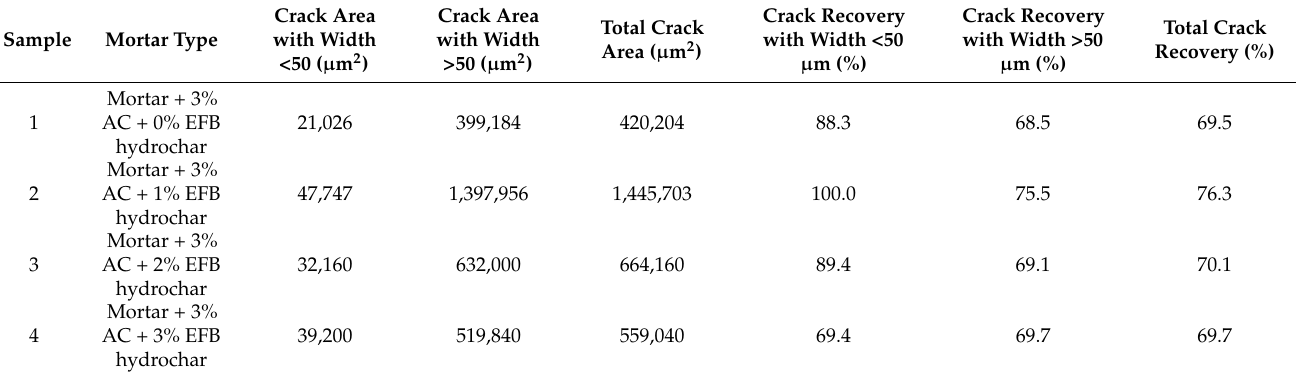
Table 14. Recapitulation of mortar crack recovery without and with the addition of EFB